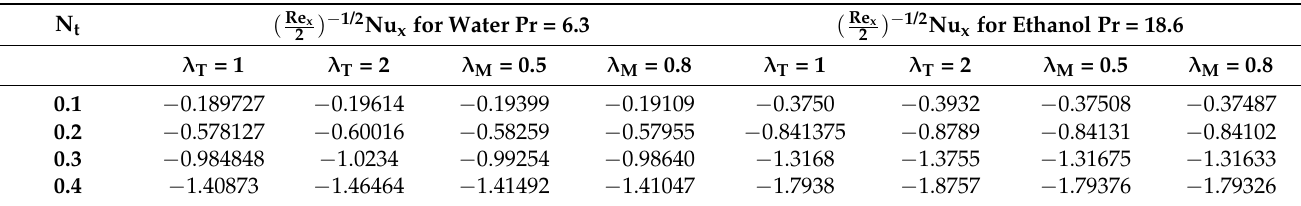
Table 3. Nusselt number for both fluids with β = 0.1, M = 1, γ = 0.2,A = 0.8.